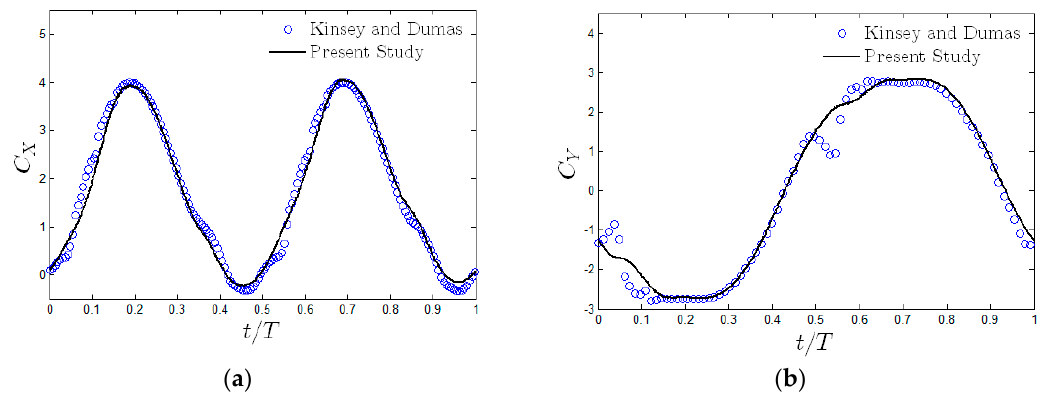
Figure 6. Comparison of results by Kinsey and Dumas and the present study, in terms of ( a ) thrust coefficient and ( b ) lift coefficient.